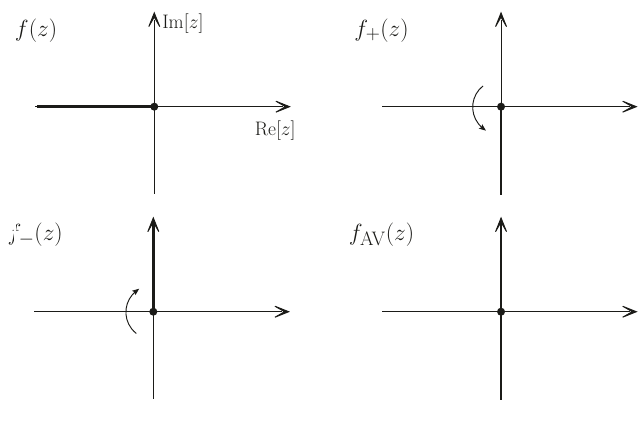
Figure 14 . Average